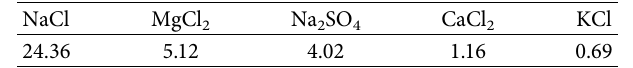
Figure 1: XRD patterns of CSA. Table 3: Composition of artificial seawater (g/L).